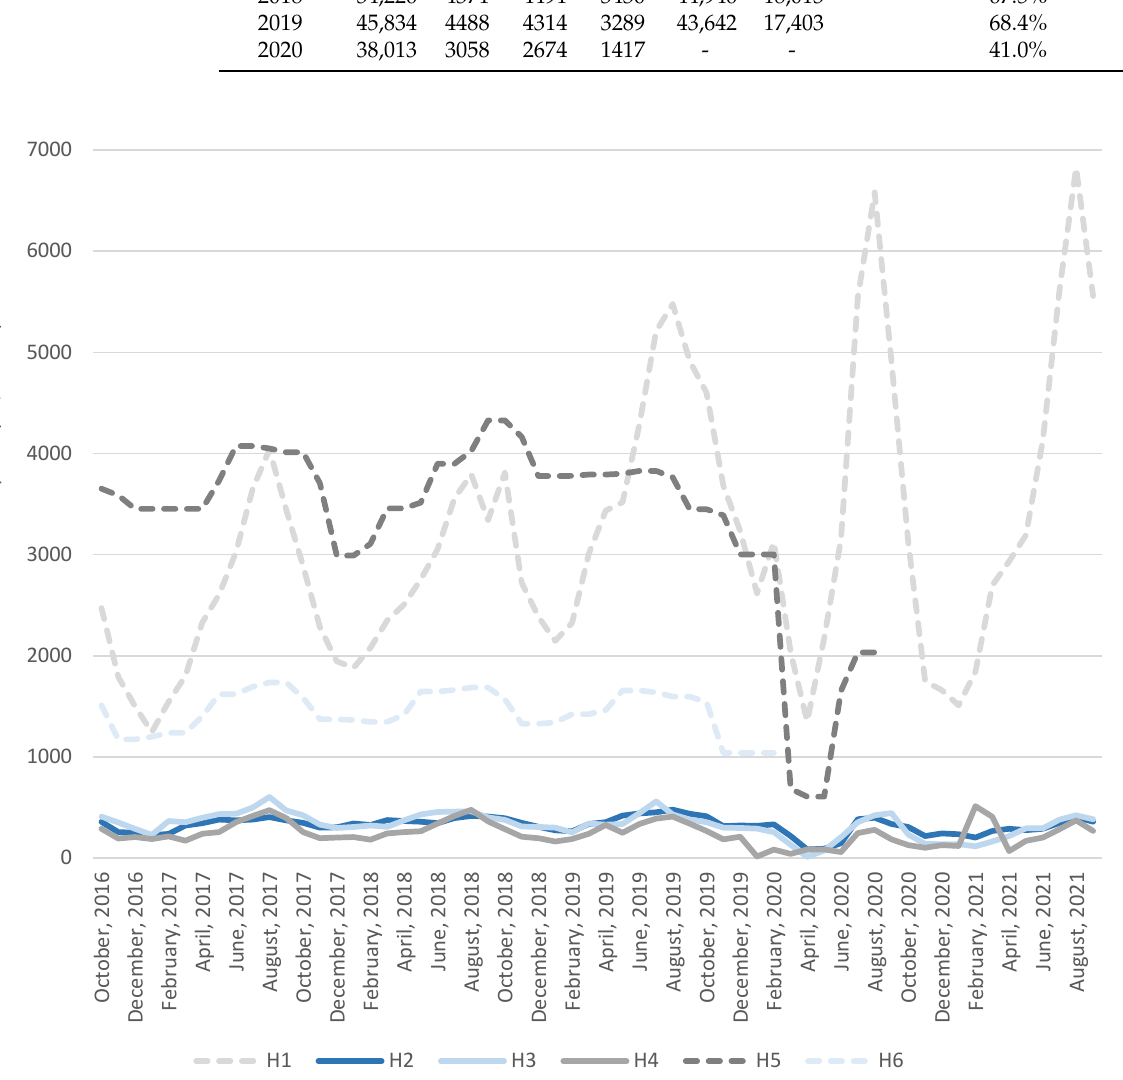
Figure 4. Water consumption per hotel and month. Table 17. Hotels’ water consumption during the later years and average occupation rate. Actual Water Consumption for Each Hotel (m 3 )